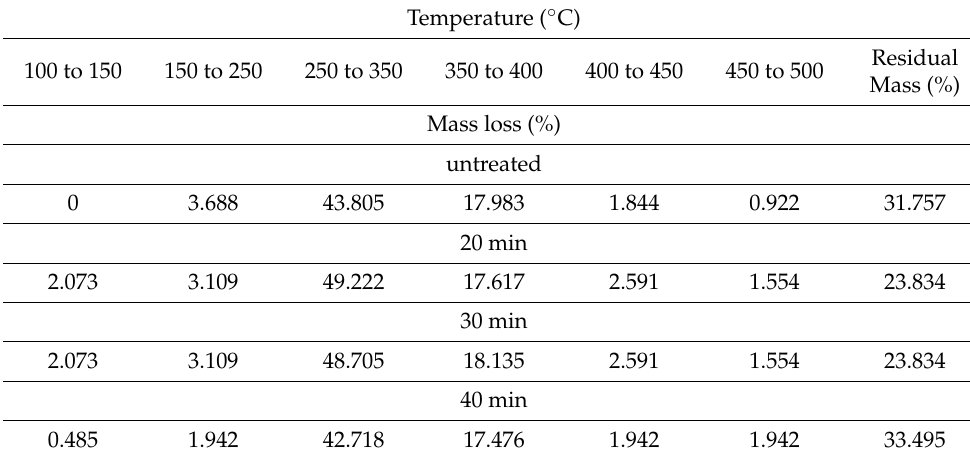
Figure 2. TG/DTG curves of coated MDF residues (untreated and torrefied for 20, 30 and 40 min), dashed lines represent mass loss with temperature and solid lines represent the fist derivate. Table 2. Mass losses (%) due to thermal decomposition of untreated × torrefied MDF residues according to temperature